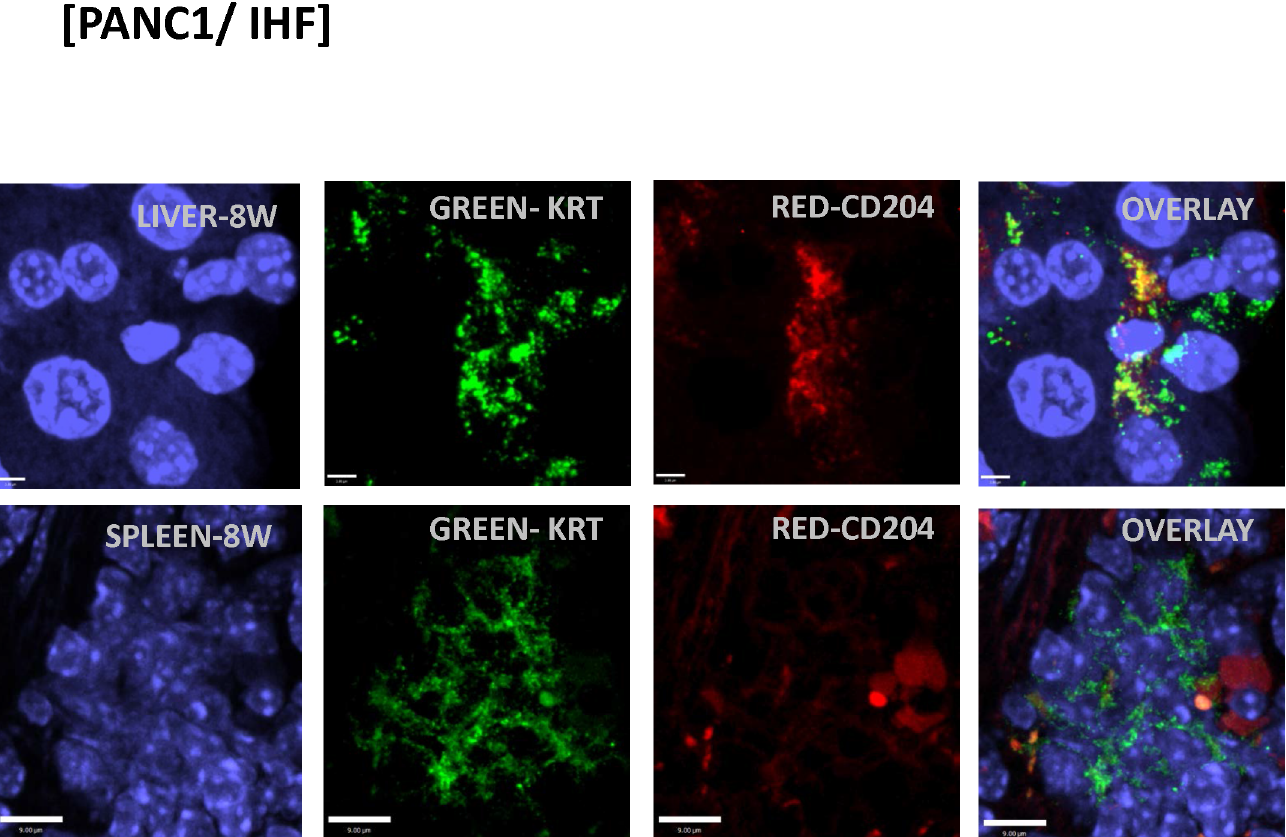
Fig 9. Immunostaining of human MTFs after orthotopic transplantation into mice. Cultured humanMTFs were orthotopicallytransplantedinto mouse pancreas. At 8 weeks followingimplantation, tissues were harvestedand examinedby confocalmicroscopy. Representative confocalimages of liver or spleen( LIVER-8W, SPLEEN-8W ) are shown. Nuclei were stained with DAPI (Blue). The same cells were also dual stained with various fluorescent markers specific for epithelial marker cytokeratin ( KRT ) or macrophage ( CD204/206 ). Note that the CD204-expressing cell is no longer